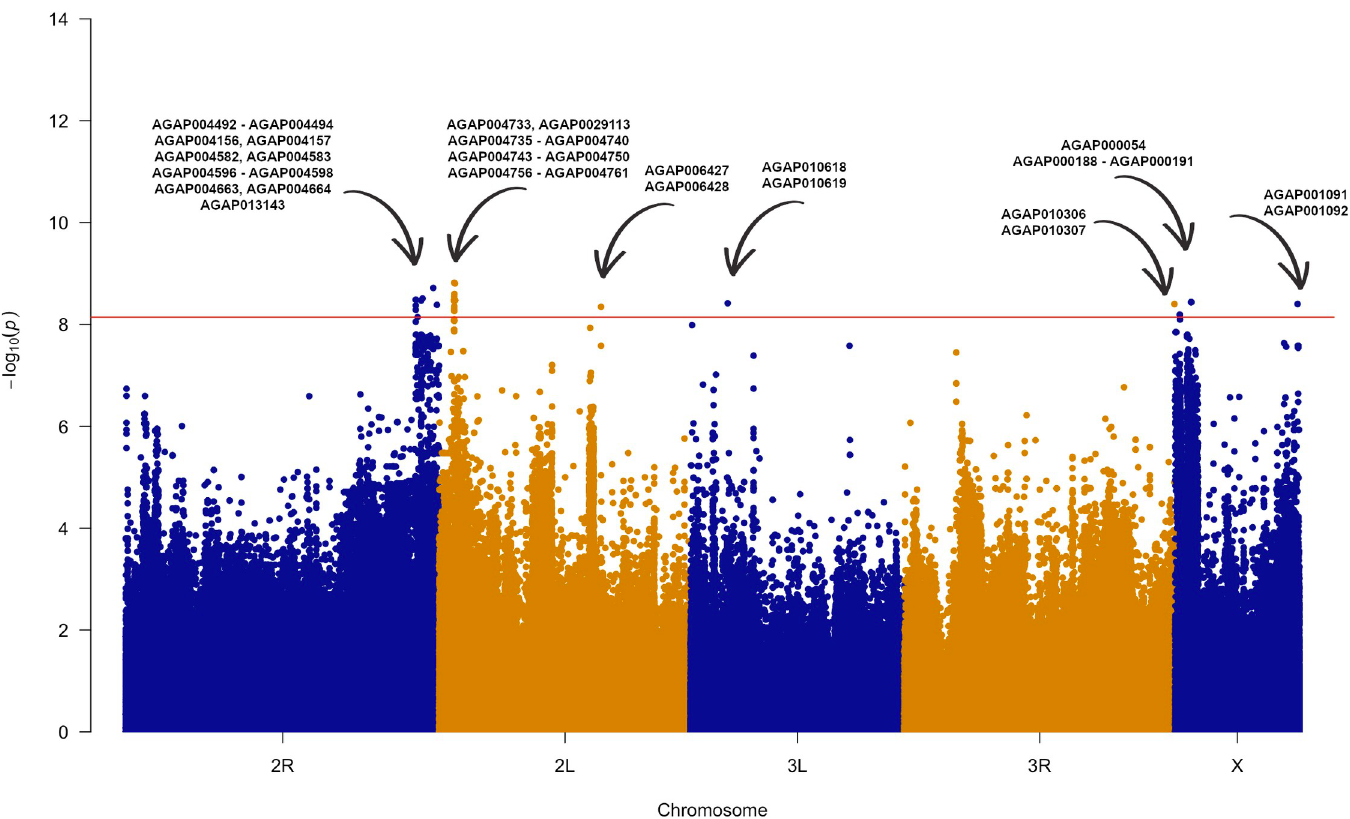
Fig 4. Manhattan plot comparing reselected and susceptible populations. GWAS-like analysis with populations as proxies for phenotype calculated using pyseer, likelihood ratio test p-values are plotted with the FDR p cut-off of p = 7.2e-9 shown with a red line. Alternative colours show the split between chromosomes. Each individual point is a SNP along each chromosome (x) and -log 10 p value (y). Annotated genes are predicted from SNPEff, contiguous ranges are shown with ‘-‘. Corrections for inversions and clonality were performed to account for population